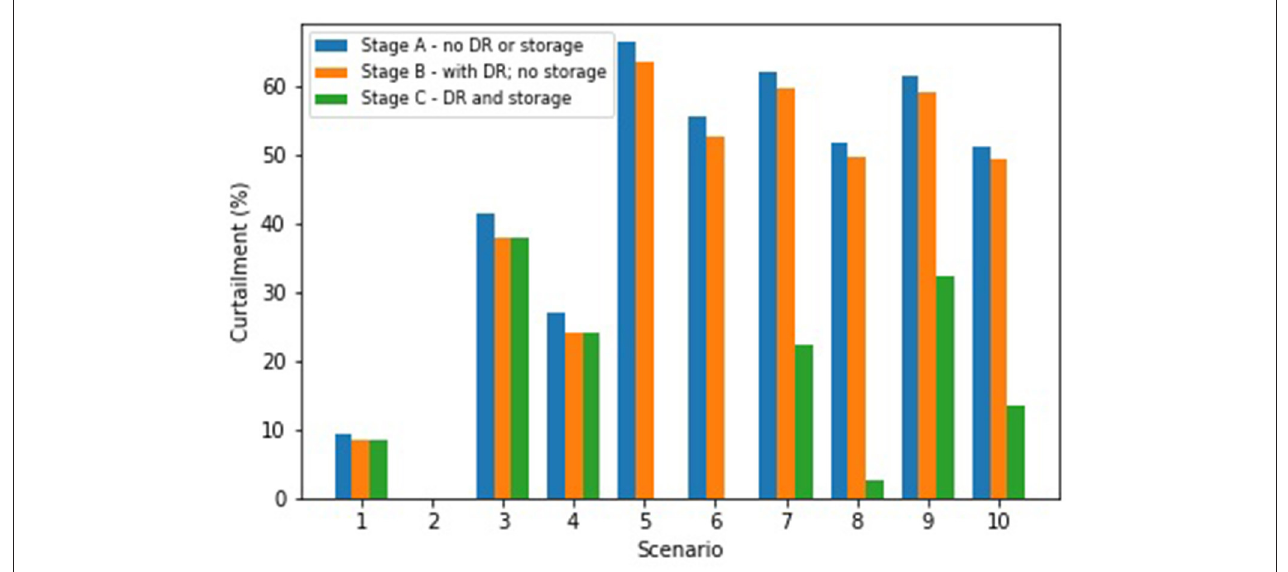
FIGURE 7 | Annual average curtailment value across all scenarios and stages. Curtailment in Stage C of Scenarios 1 through 4 is identical to Stage B, as there is no storage capacity added to the system. Note that if scenarios appear to not have values for a particular stage it is due to that value being zero or near zero.